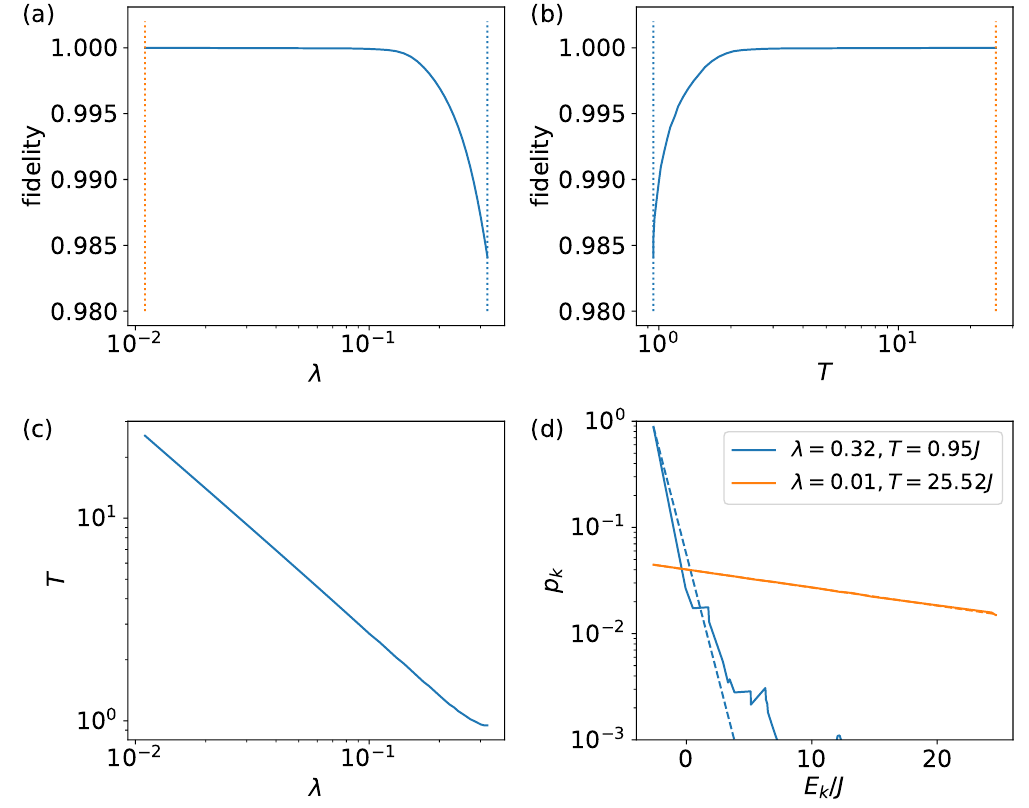
Figure 8: The fidelity between the steady state and the corresponding thermal state as a function of (a) the free parameter λ and (b) the temperature T . The temperature of the thermal state is fixed by optimizing the fidelity and is shown in (c). (d) com- pares the distribution of the steady state (solid lines) and the corresponding thermal state (dashed lines) on the eigenbasis of the system at two different λ [ marked by dashed lines in (a) and (b) ] . The parameters are M = 4, N = 4, U = 4 J , γ = 0.01 J